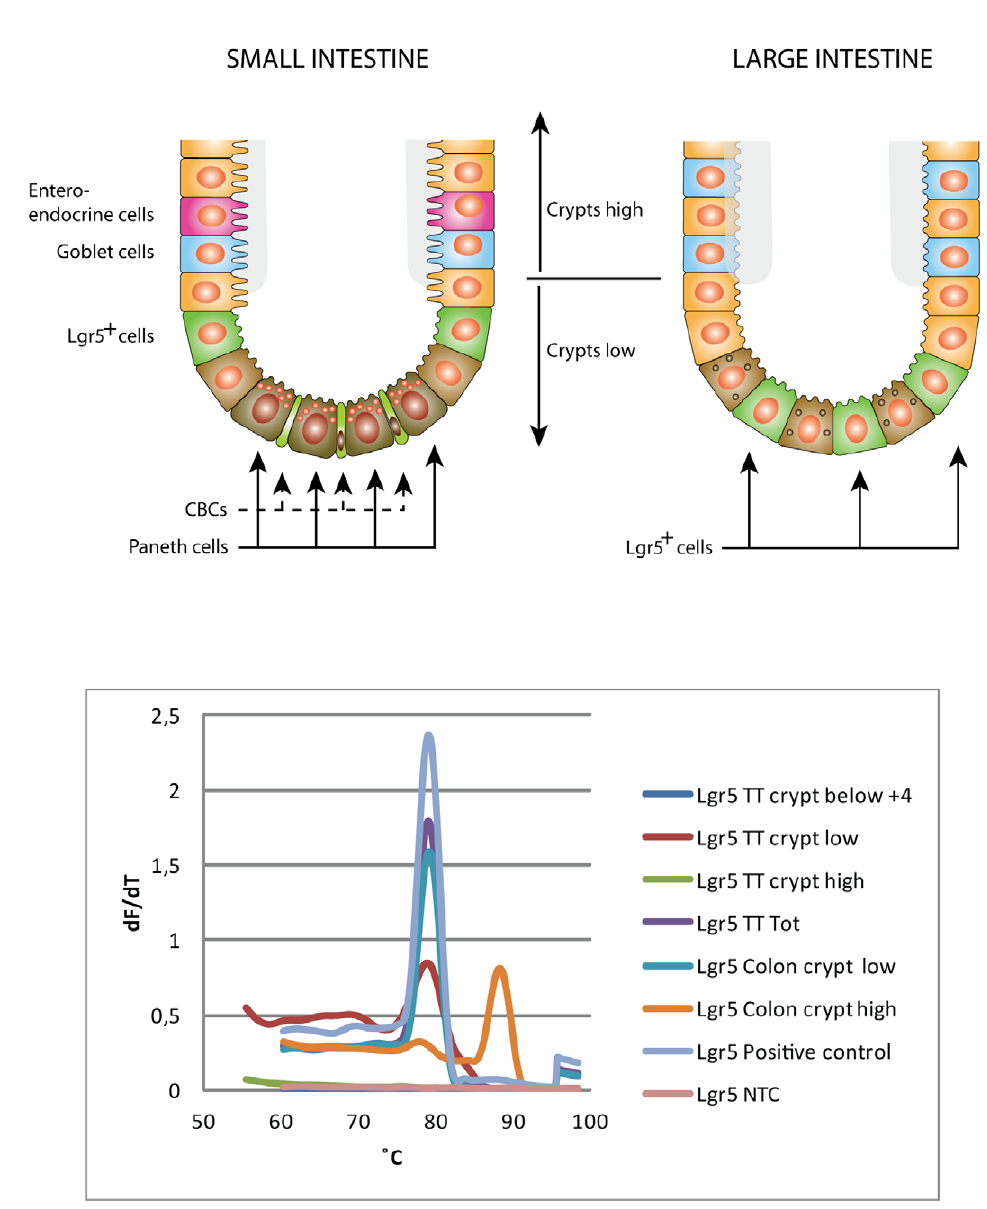
Figure 2. Lgr5 gene expression in normal human intestine. a) Schematic illustration of how the crypts of human intestinal tissue were divided into different populations , b) Cells from the different populations described above were dissected by LMD from normal human small intestine and colon, and inflamed small intestinal tissue. RNA were isolated from the dissected cells and analyzed by RT-PCR for the expression of Lgr5. Amplification of Lgr5 PCR producs were verified by correct melting